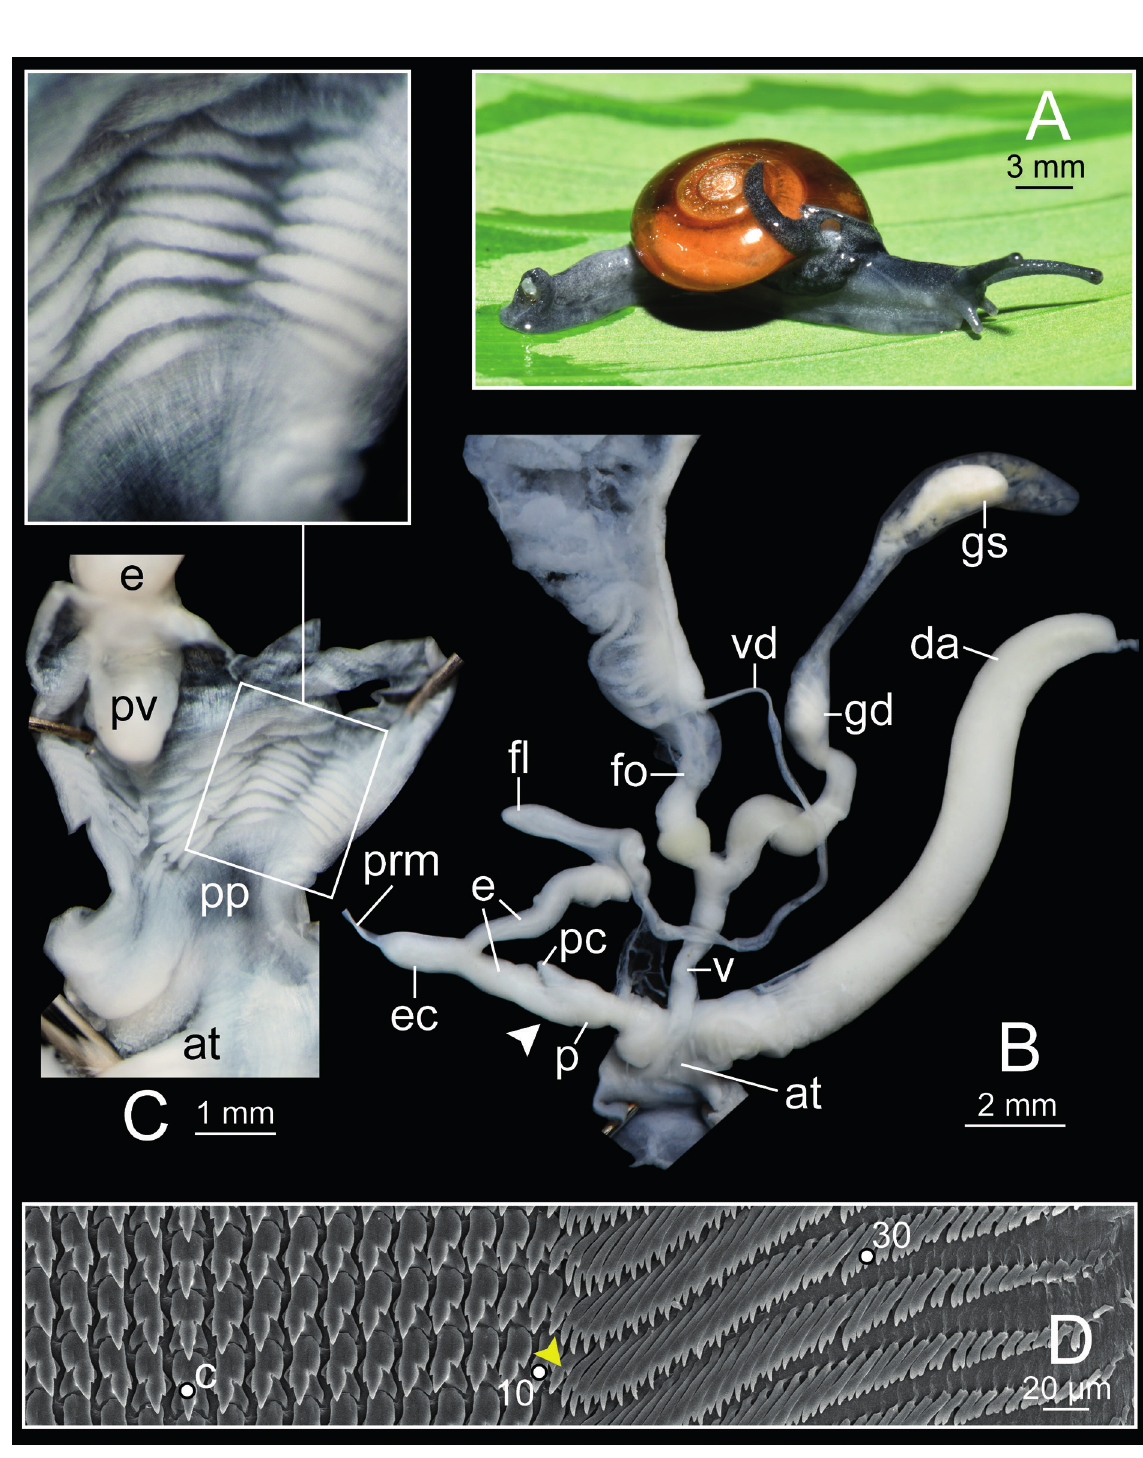
Fig. 7. Sarika nana Pholyotha & Panha sp. nov., paratype (CUMZ 7908). A . Living snail. B . General view of genital system. C . Internal structure of penis. D . Representative SEM image of the radula. Central tooth indicated by ‘C’; yellow arrow heads indicate lateral teeth with the transition to marginal teeth; white arrow heads indicate the end of